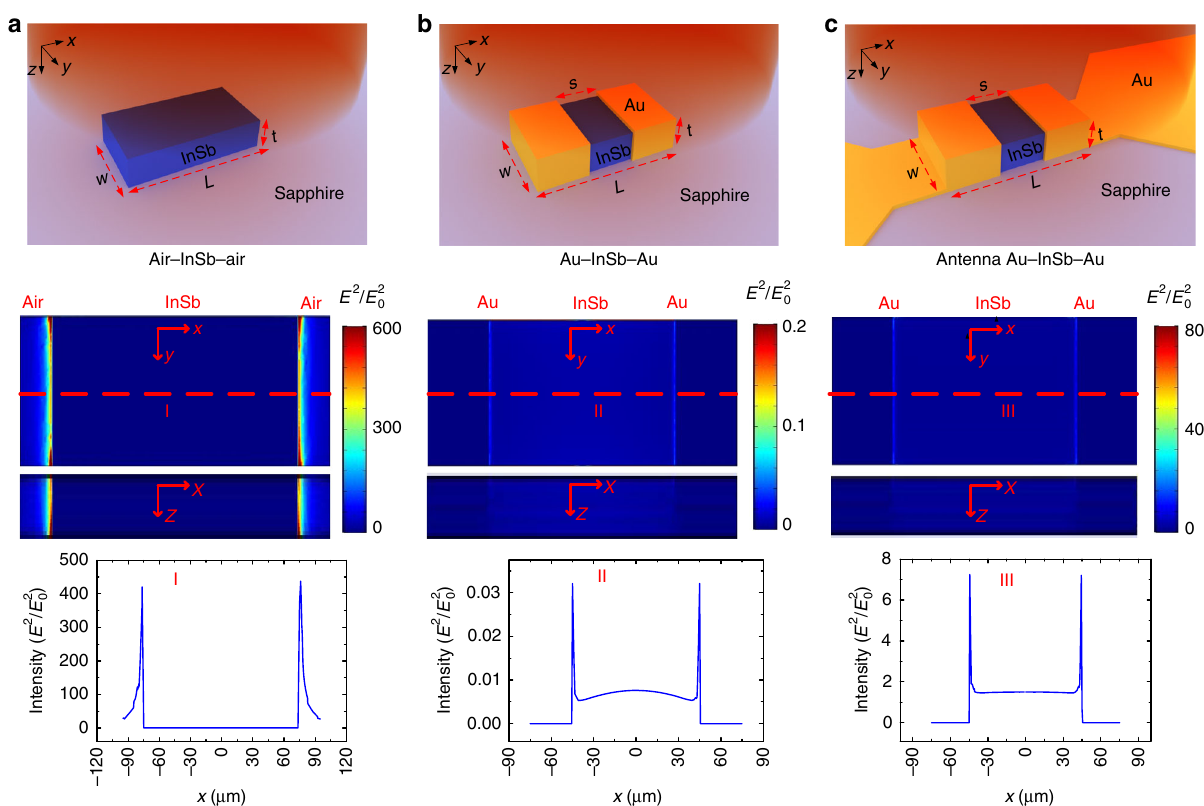
Fig. 2 Numerical simulations for the antenna-assisted subwavelength ohmic metal – semiconductor – metal (OMSM) structure made of gold and InSb. Excitation of localized SPPs, the 2D distributions of E 2 / E 0 2 in x – y ( z = 0) and x – z ( y = 0) planes, and distribution of E 2 / E 0 2 along the red dash (half width) line for the incident 0.151 meV photons in a a bare InSb slab ( L = 150 μ m, W = 50 μ m, and t = 10 μ m), b the subwavelength Au – InSb – Au structure (the same InSb slab with s = 90 μ m), and c the antenna-assisted subwavelength Au – InSb – Au structure with s = 90 μ